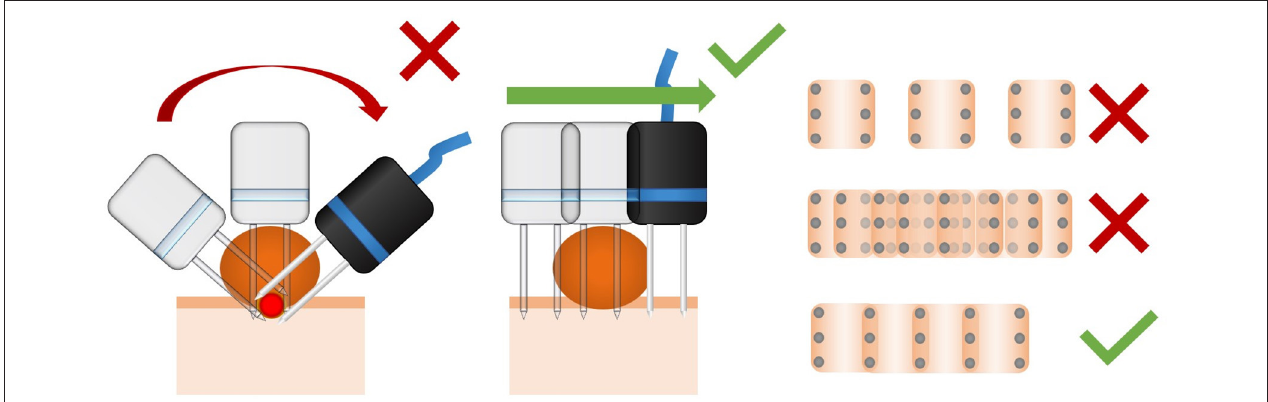
FIGURE 10 | Dos and don’ts about the technique of electric field delivery using needle electrodes. At left, a common mistake during the treatment of rounded lesions is the application perpendicularly to the surface. In this way, the tumoral bed may not be correctly treated, and the center of the mass may be overtreated. In the middle, the delivery of the pulses perpendicularly to the surface where the tumor lies. This provides adequate treatment of the bed of the lesion. At right, is a scheme of the distance between the applications of a 6-needle electrode. As it can be seen, if they are too separated (up), untreated areas may lead to a relapse. If they are too superposed (middle), overtreatment may produce necrosis and unintended tissue damage. The right distance is a slight superposition of the applications